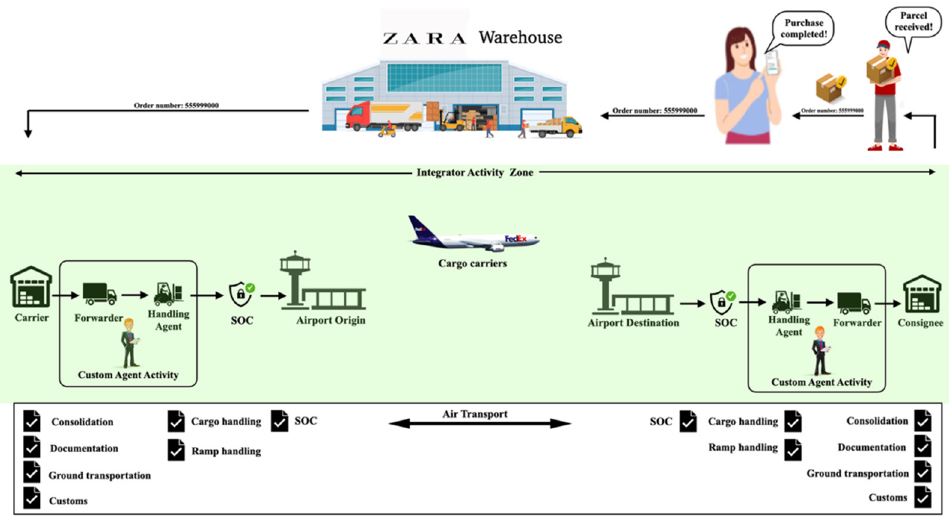
Figure 4. E-commerce process from consumer to parcel delivery. Source: Author’s own elabora- tion.